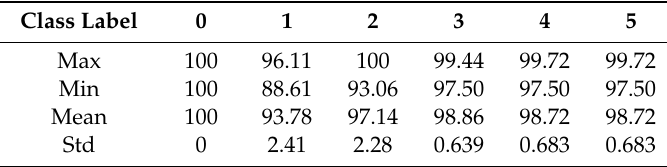
Table 3. The diagnosis accuracy of the proposed models